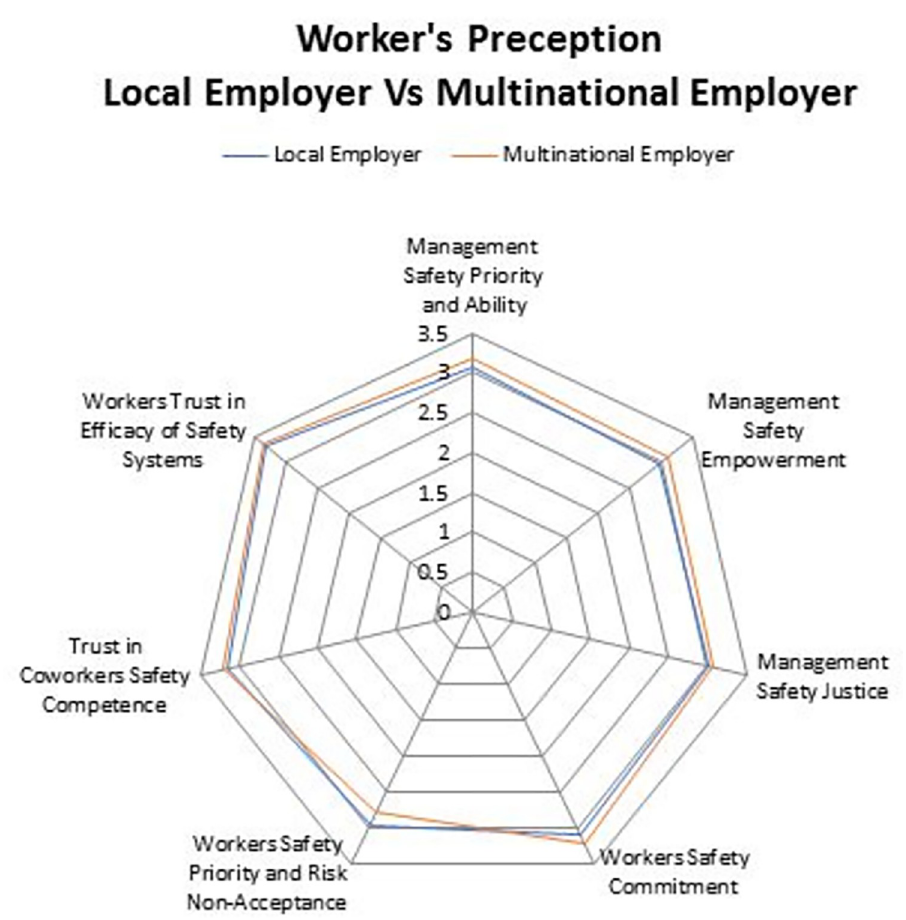
Fig 3. Worker’s perception on safety climate in both MNCs &